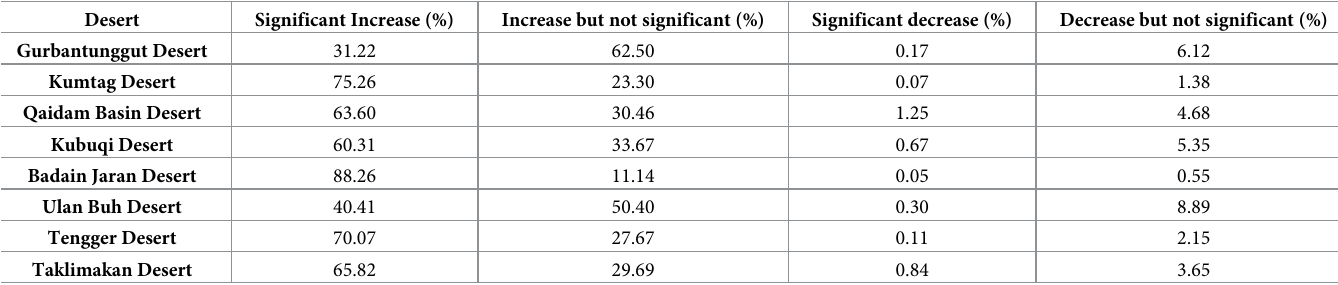
Fig 4 also shows the relative frequency distributions of the greening and browning trends over longitude and latitude. The area with greening trends was positively correlated with the desert area. Although the area with browning trends was very small, it was distributed over longitudes and latitudes with large desert areas. The NDVI trends differed for different deserts (Table 1). The proportion of greening in the Badain Jaran Desert was the highest among the deserts at 88.26%, which increased signifi- cantly, followed by the Kumtag Desert (75.26%) and Tengger Desert (70.07%). While the pro- portion of greening in the Gurbantunggut Desert was only 31.22%, the lowest of the deserts. Table 1. The NDVI trends in different deserts. Desert Significant Increase (%) Increase but not significant (%) Significant decrease